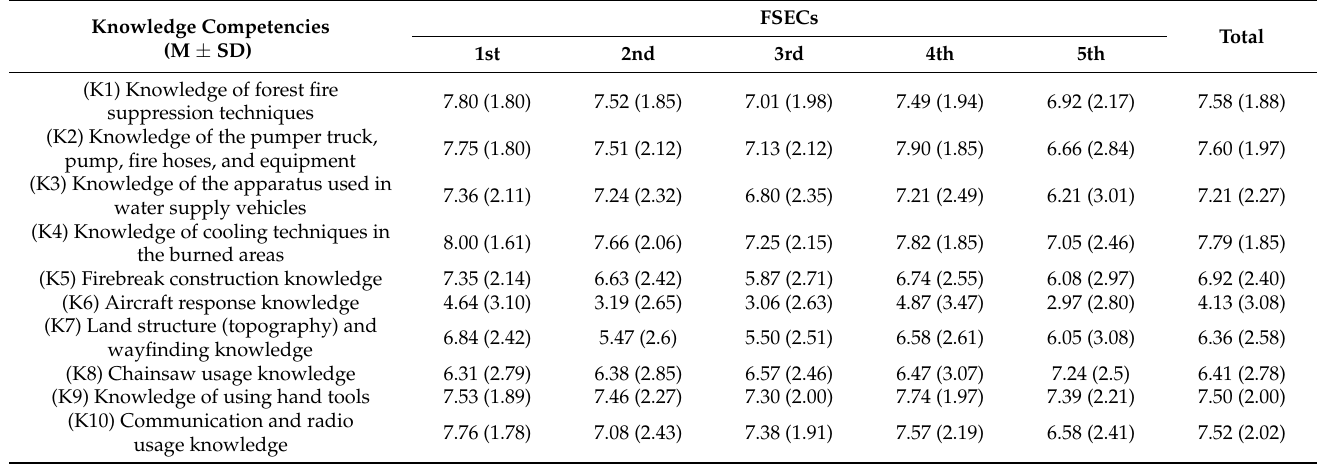
Table 9. Knowledge and experience competencies of Turkish FFFs.